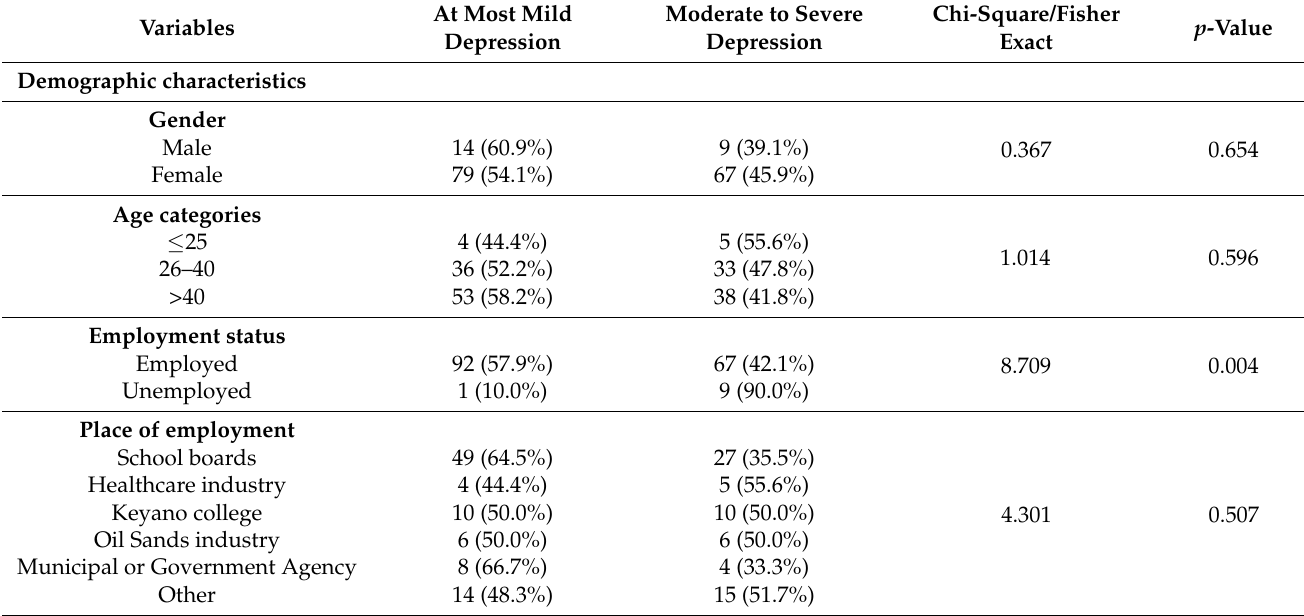
Table 2. Chi-square test of association between demographic, clinical, and COVID-19 characteristics and potential